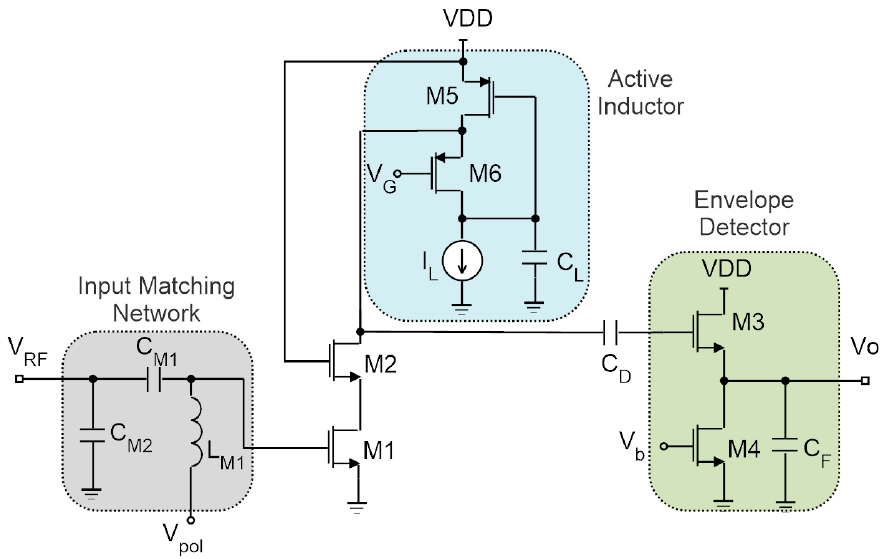
Figure 10. Schematic of the tuned RFED WuR with narrow-band cascode LNA and envelope detector, where the LC tank of the LNA is composed of an integrated active inductor.